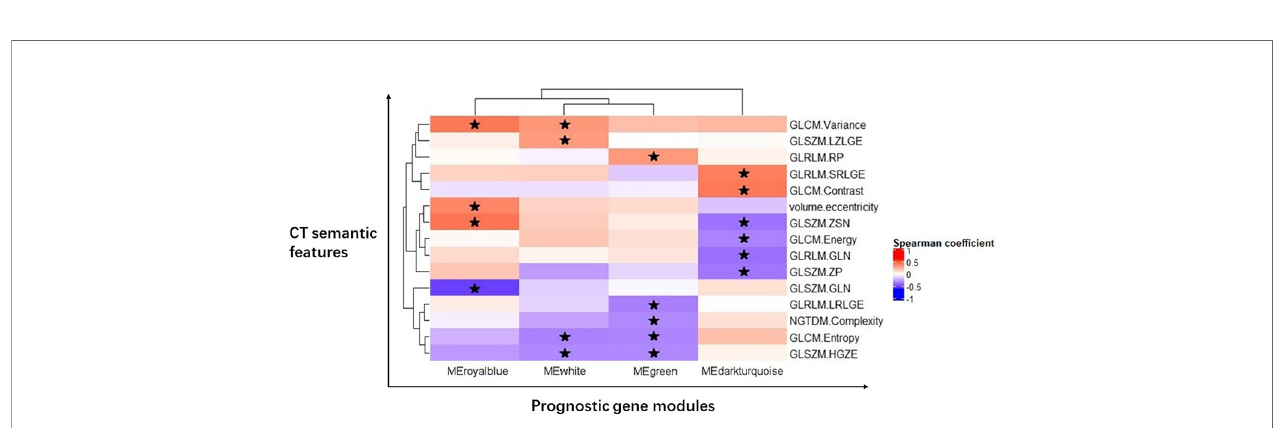
FIGURE 2 | Radiogenomic map revealing 19 statistically signi fi cant associations between 15 CT semantic features and four prognostic gene modules in GC. Signi fi cant pairwise correlations (P < 0.05) are indicated with star symbols. The corresponding correlation coef fi cients are displayed in a heatmap; the red color indicates positive correlations, and the blue color indicates negative